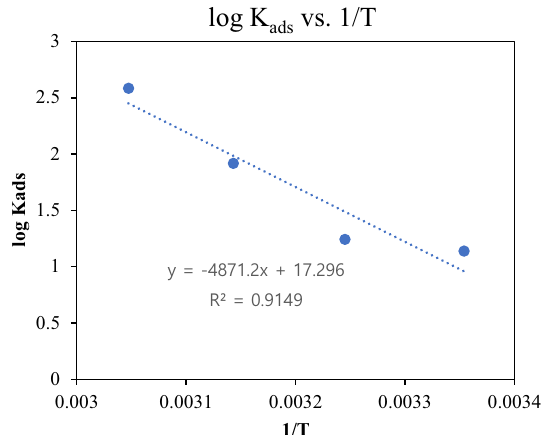
Figure 3. Relationship between log K ads vs. 1/T.